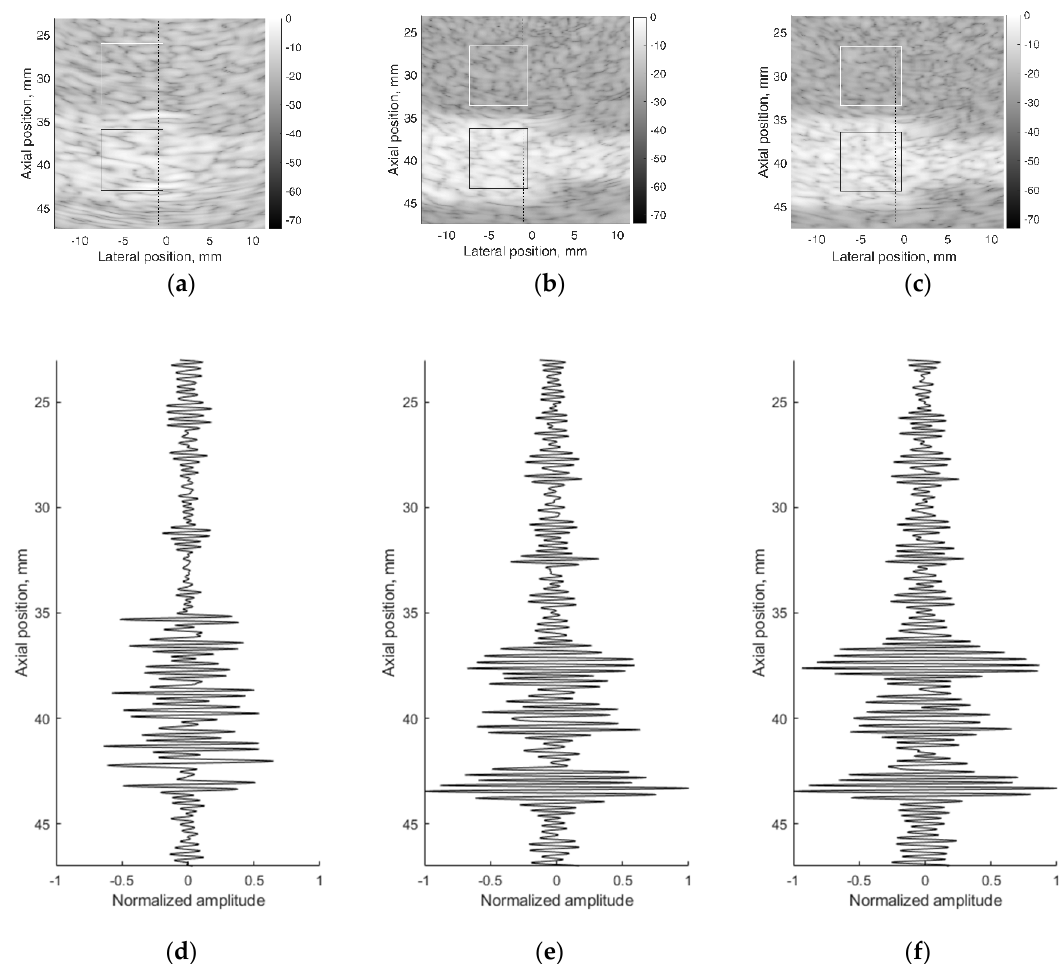
Figure 11. B-scan sub-images of background TMM with contrast inclusion having +12dB stronger scattering: ( a ) physical contrast phantom; ( b ) digital contrast phantom with 10 scatterers per resolution cell (SPRC), ( c ) digital contrast phantom with 15 SPRC and RF signals of corresponding depth ranges along scanning line at lateral (–1) mm position: ( d ) physical contrast phantom, ( e ) digital contrast phantom with 10 SPRC, ( f ) digital contrast phantom with 15 SPRC. The regions (7 × 7 mm) outlined with the white and black lines were taken for B-scan intensity evaluation.